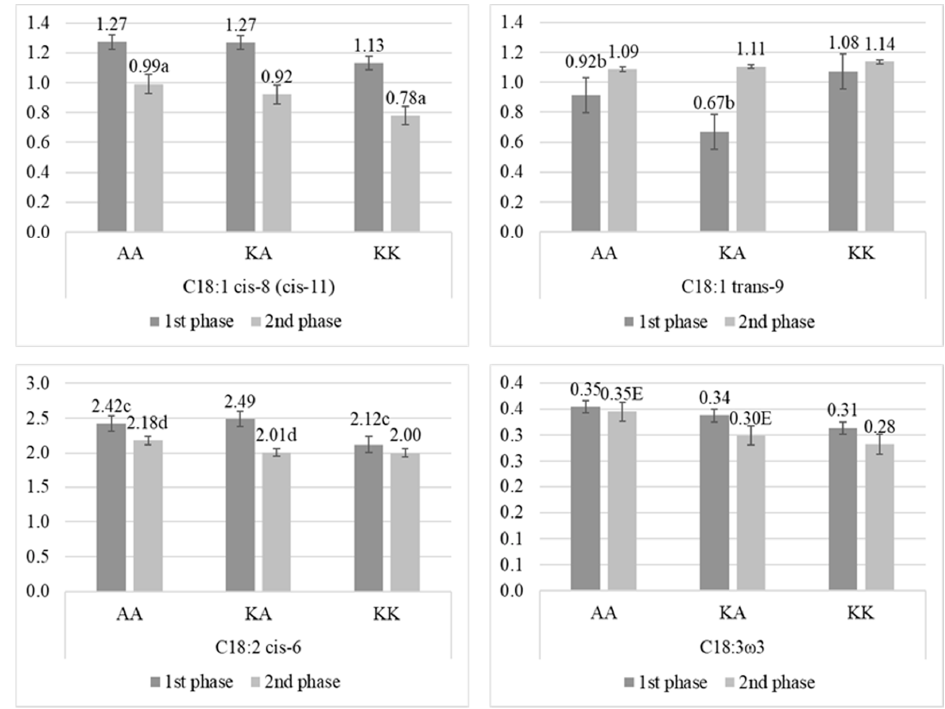
Figure 6. Percentage (mean ± SE) of fatty acids with 18 carbon atoms in milk from Polish Holstein-Frisian cows during the first and second phase of lactation depending on K232A single nucleotide polymorphism (SNP) in diglyceride acyltransferase ( DGAT1 ) gene. a, b, c, d—values differ significantly between polymorphisms within fatty acid ( p < 0.05); A, B, C, D—values differ highly significantly between polymorphisms within fatty acid ( p < 0.01).